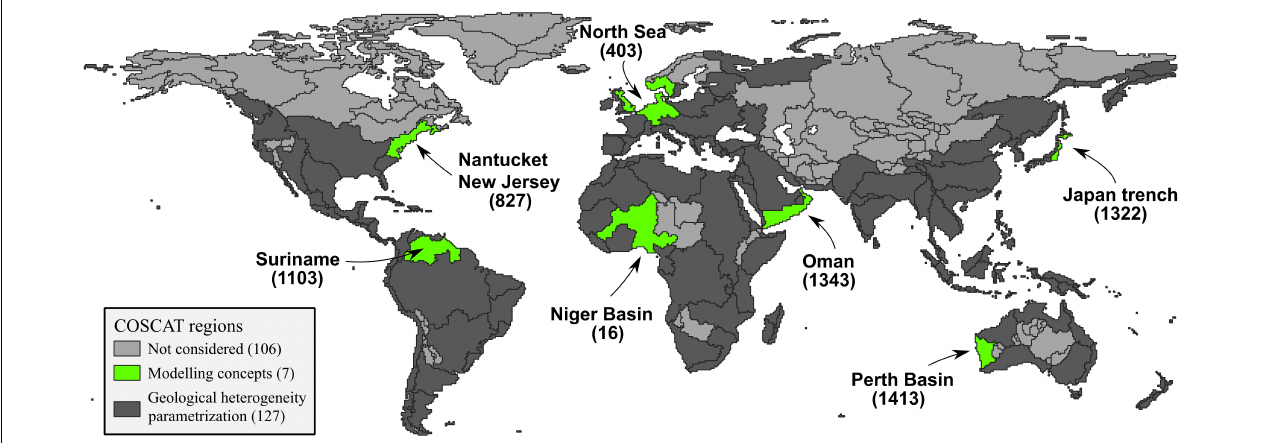
FIGURE 5 | COSCAT regions selected for comparison of the two modeling concepts and the geological heterogeneity parameterization study. Northern arctic and inland COSCAT regions are not considered for this study. COSCAT region names (in brackets) correspond to areas with proven or highly possible presence of offshore fresh groundwater reserves (Post et al.,